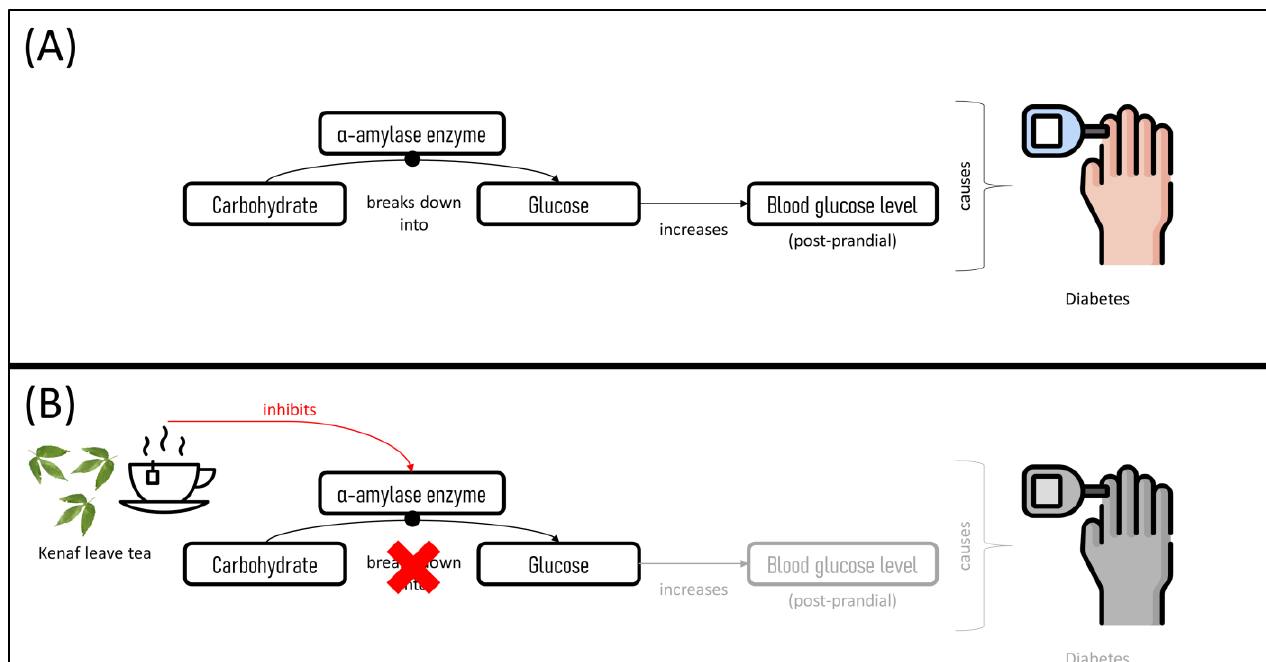
Figure 9. Graphical illustration of kenaf leaf tea mechanism in addressing diabetes. ( A ) Without kenaf leave tea. ( B ) With kenaf leave tea.